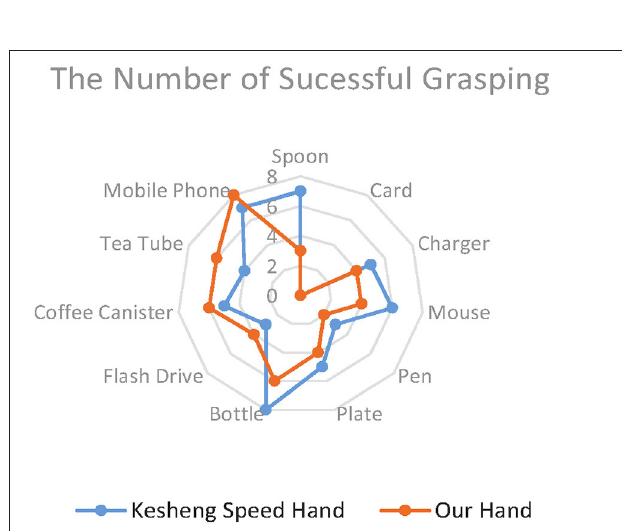
FIGURE 10 | Average scores of the prosthetic hands in the grasping experiments.